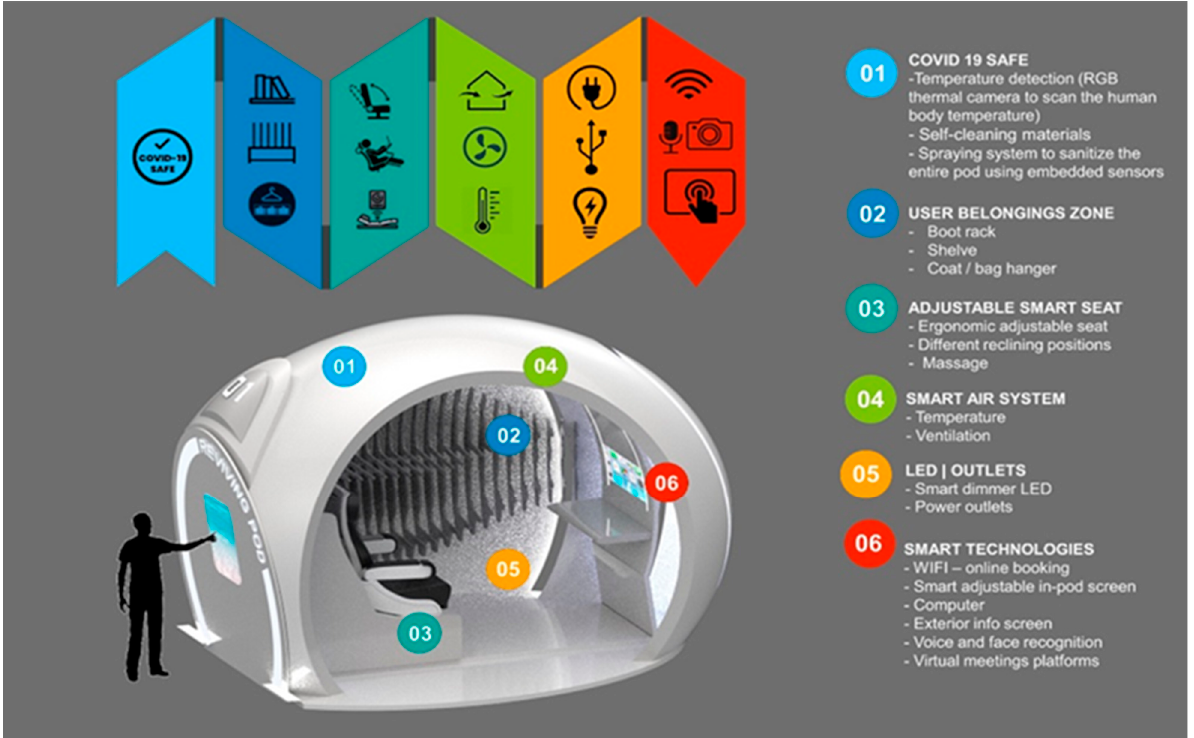
Figure 12. Diagram indicating COVID-19 precautions in the pod’s design, illustrating the personal belongings zone, adjustable smart seat, LED outlets, and various smart technologies used within the Reviving Pod, as designed by the authors.